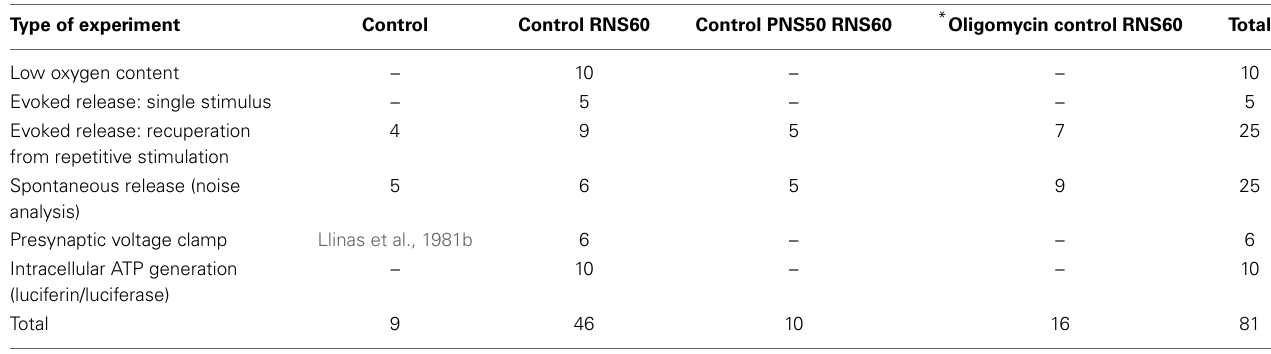
Table 2 | Summary of experiments comprising database for this study.